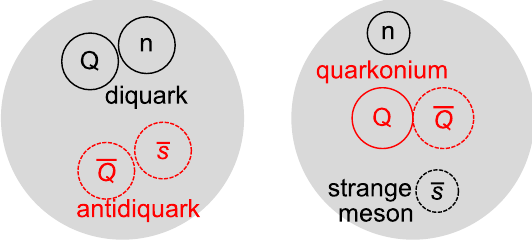
Figure 1 . Schematic representation of heavy-light hadro-quarkonium (right) and compact tetraquark (left)